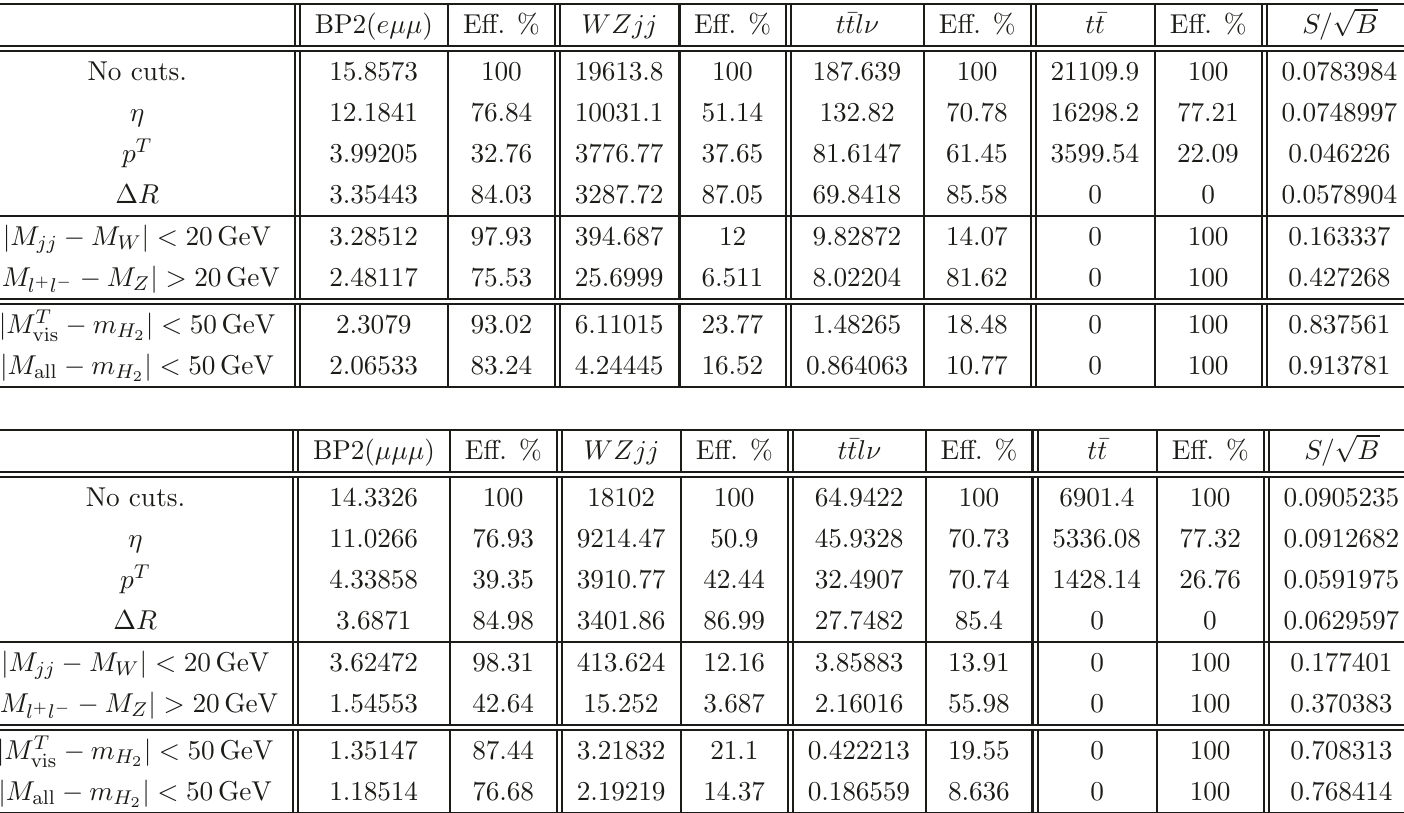
= 100fb − 1 . Universal acceptance cuts = L > 10 µ